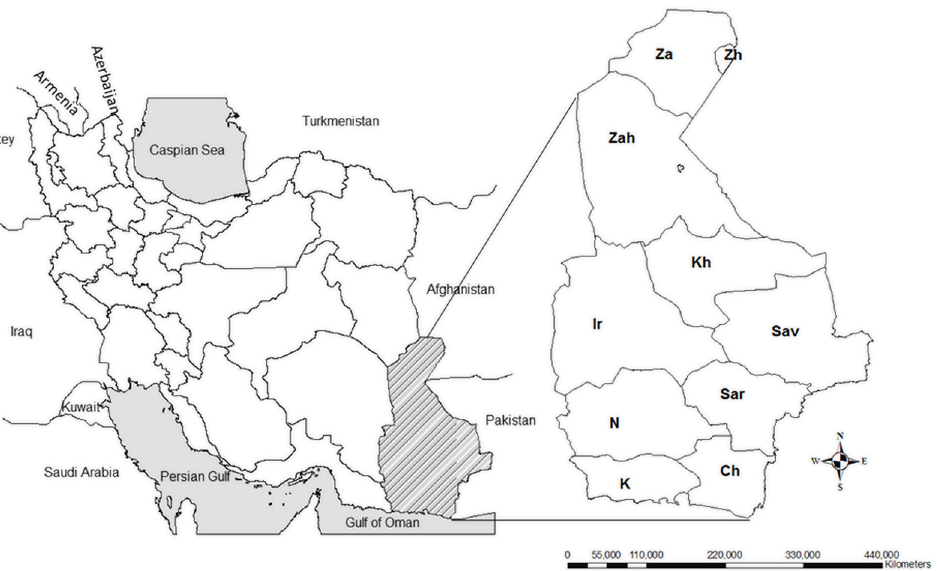
Fig 1. Map of Sistan va Baluchestan province in southeast Iran. Sampling from butchers and slaughterhouse workers was performed in the different counties of Sistan va Baluchestan province including: Zahak (Zh) and Zabol (Za) in the north, Zahedan (Zah), Iranshahr (Ir) and Khash (Kh) in the centre, and Saravan (Sav), Sarbaz (Sar), Nikshahr(N), Konarak (K) and Chabahar (Ch) in the south.